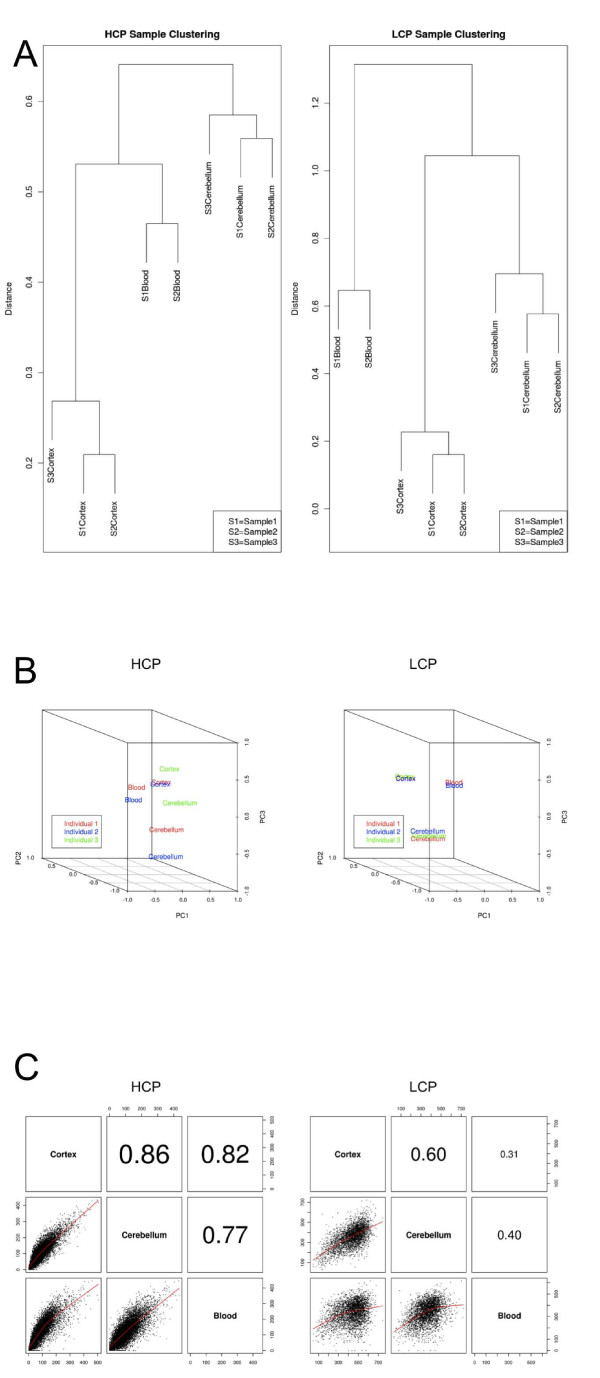
DNA methylation across LCPs is strongly associated with tissue type. (a) MEDIPS scores across both HCPs and LCPs can be used to accurately cluster samples by tissue type, but the strength of clustering, indicated by Pearson dissimilarity on the y-axis, is much higher in LCPs. (b, c) This pattern is reflected in three-factor PCA plots (b) and correlation analyses (c), with LCPs demonstrating stronger tissue-specific patterns of DNA methylation than HCPs.